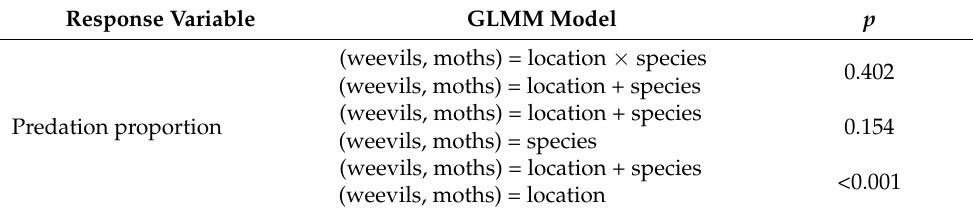
Table 2. Generalized linear mixed effects models (GLMMs) used to analyze the differences in the proportion of acorns predated by weevil and moth larvae between locations (forest and isolated trees) and oak species. The p -values indicate the significance of the likelihood ratio test among pairs of models ( n = 254).